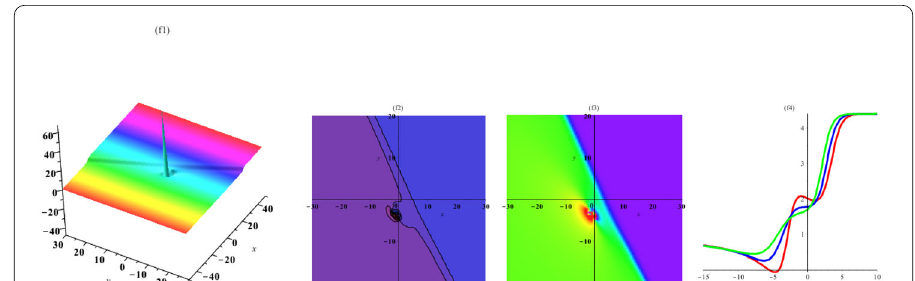
Figure 5 The plot of lump–kink (4.5) with fractional order α = 0.5